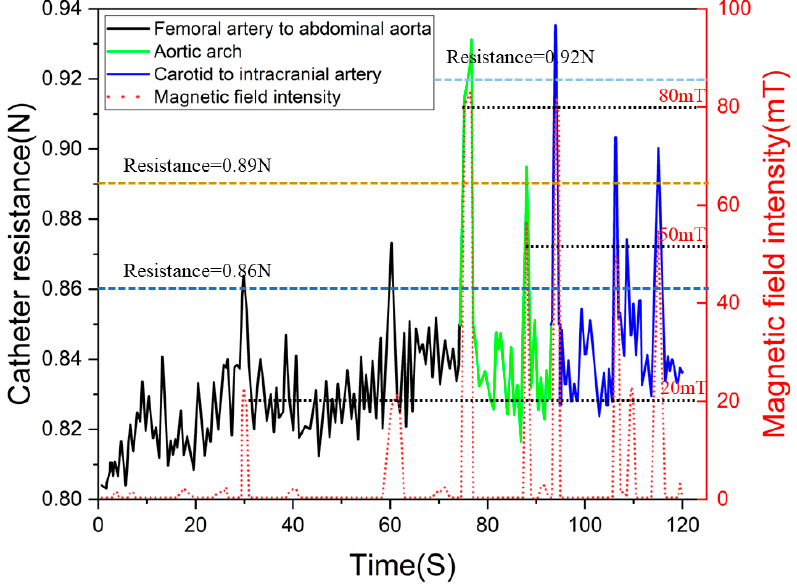
Figure 19. The in vitro model control experimental data.